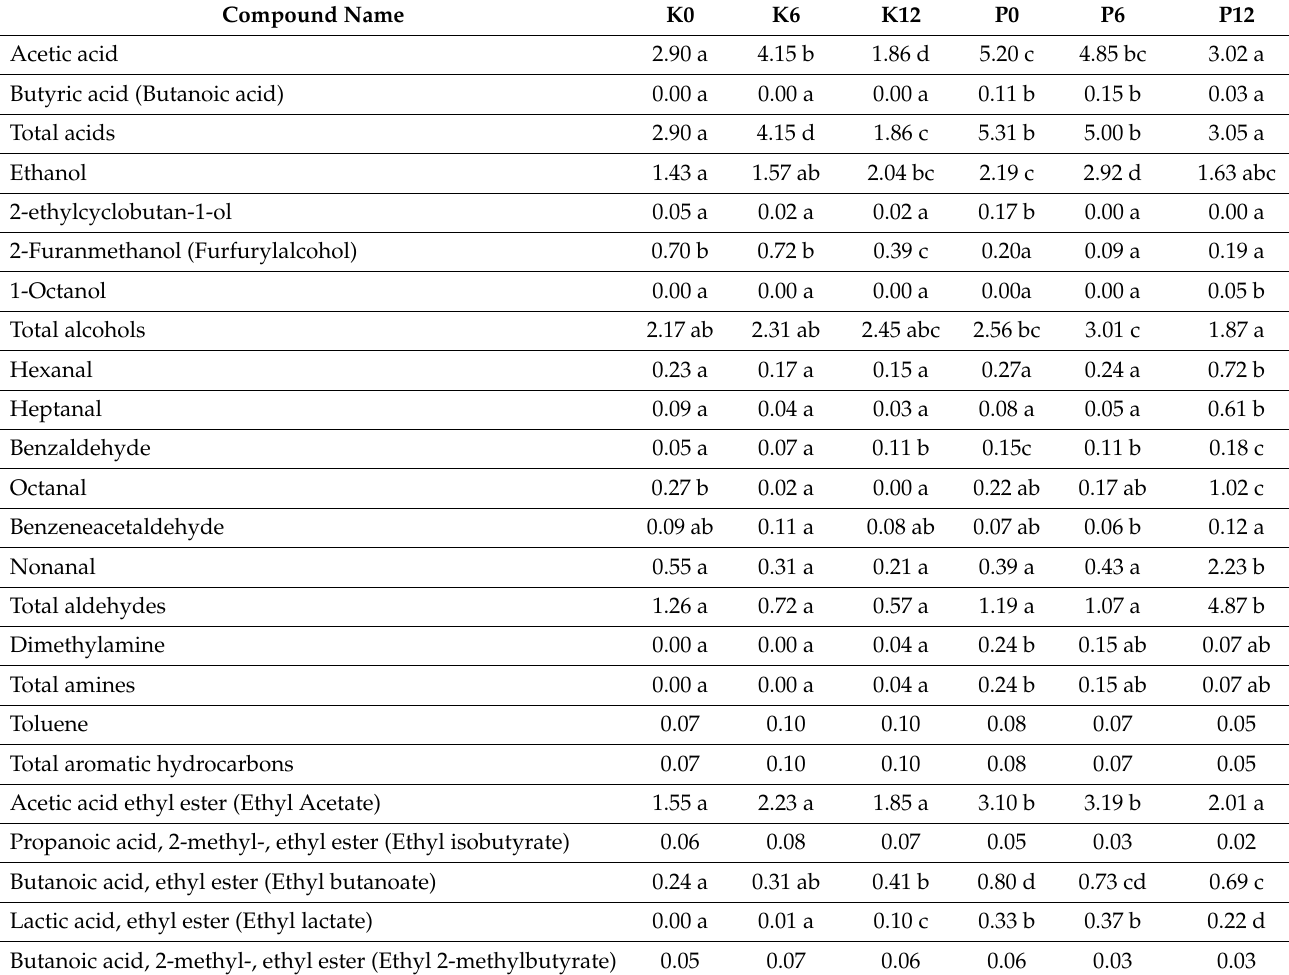
Table 3. Relative content (%) of volatile organic compounds in CONTROL and PROBIOTIC sausages after ripening after 6 and 12 weeks of